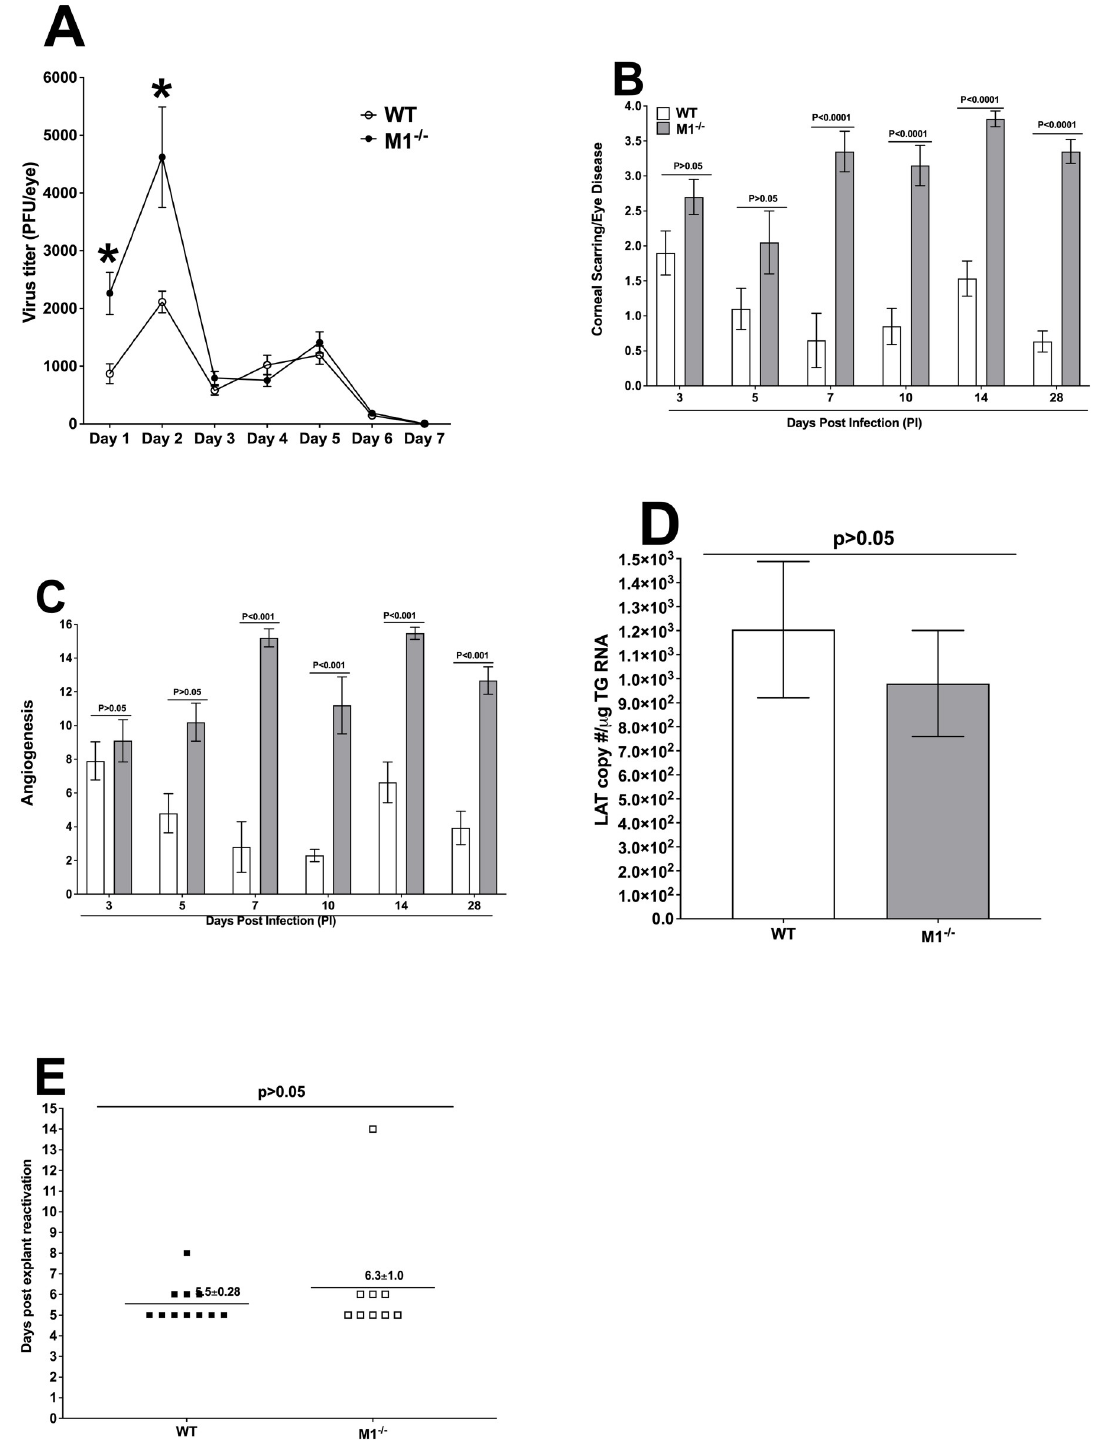
Fig 7. Virus replication, eye disease, latency, and reactivation after infection with avirulent HSV-strain KOS virus. WT and M1 -/- mice were ocularly infected with 2 X 10 5 pfu/eye of avirulent HSV-1 strain KOS following corneal scarification as described in Materials and methods. A) Virus replication in tears of infected mice. Tear films were collected on days 1–7 PI and virus titers were determined by standard plaque assays as described in Materials and methods. Each point represents the mean ± SEM of 32 eyes per group: B and C) Eye disease. Corneal scarring/corneal disease and angiogenesis were examined on days 3, 5, 7, 10,14 and 28 PI as described in Materials and methods. Scores represent the average ± SEM from 10 eyes on days 3, 5, 7 and 10, while 30 eyes for each group of mice on days 14